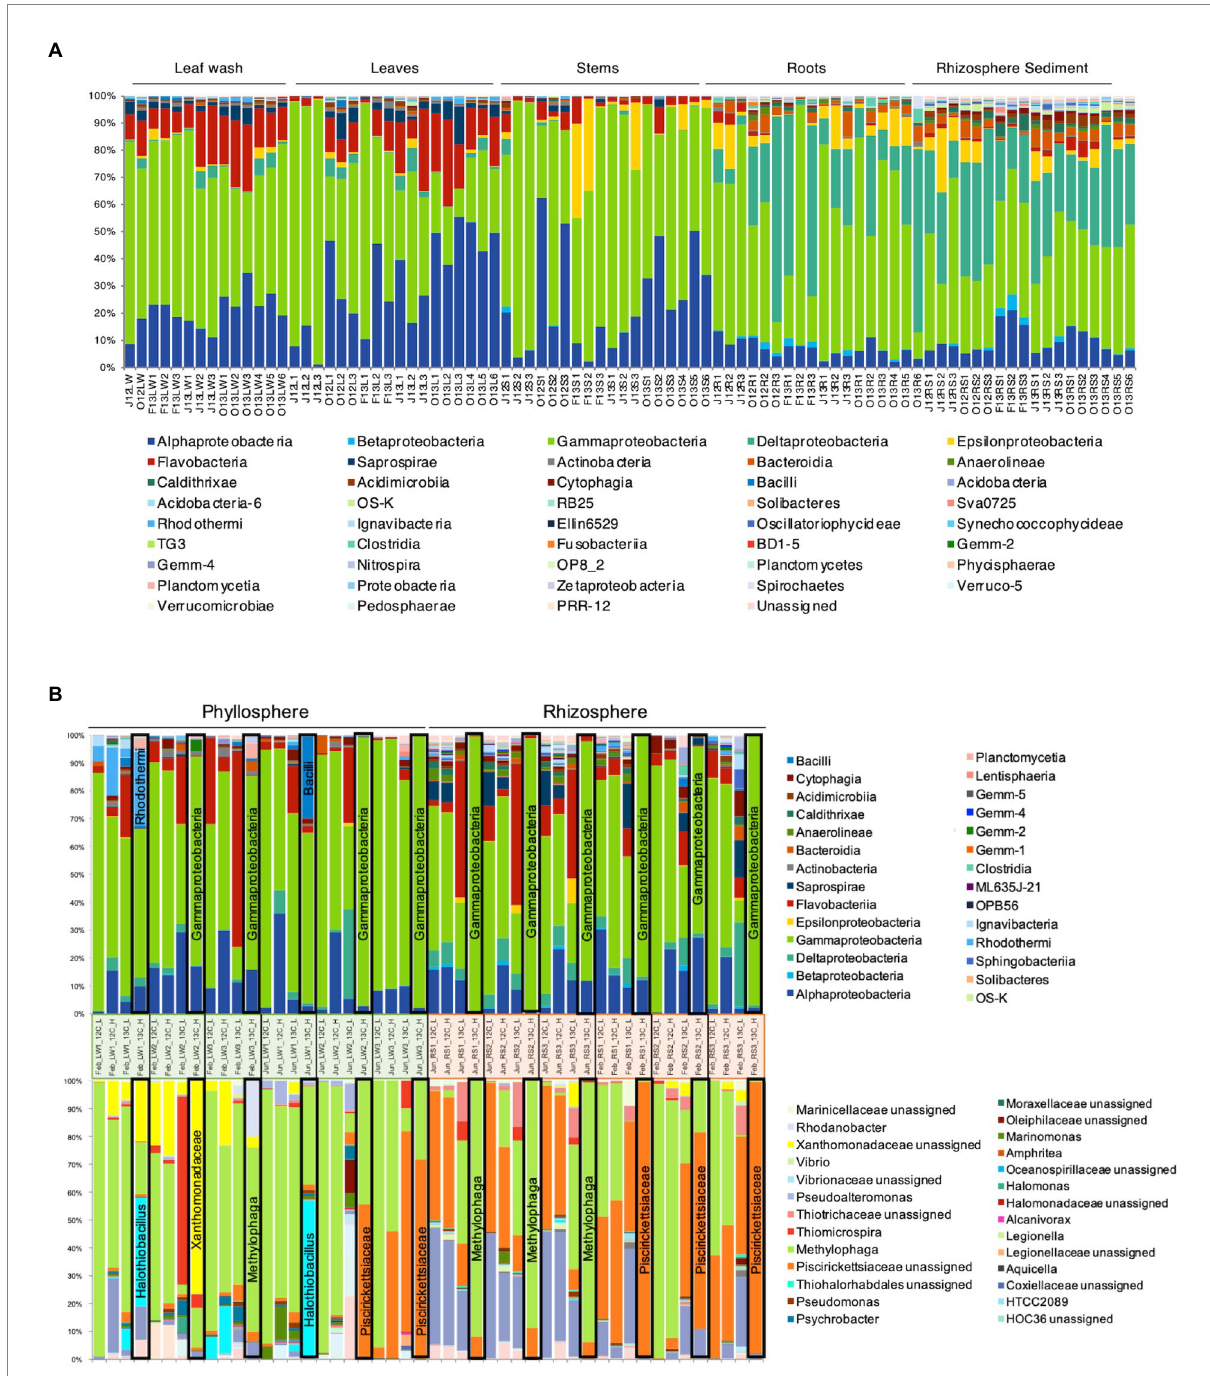
FIGURE 4 Bacterial community composition in phyllosphere and rhizosphere of Sporobolus anglicus . (A) Bacterial community composition in leaf wash (LW), leaf (L), stem (S), root (R), and rhizosphere sediment (RS) samples of S. anglicus in June 2012 (J12), October 2012 (O12), February 2013 (F13), June 2013 (J13), and October 2013 (O13) at class-level. Each column represents relative abundance of microbial taxa detected in a sample. (B) Relative distribution and phylogenetic affiliation of OTUs detected by bacterial 16S rRNA high-throughput amplicon sequencing of fractionated DNA from [ 13 C 2 ]-DMS and [ 12 C 2 ]-DMS SIP incubations of phyllosphere (leaf washings—LW) and rhizosphere samples (sediment—RS) of S. anglicus from June and February at class-level (top) and genus-level (bottom, most abundant genera) after incorporation of 100 μ mol C g –1 sample. Each column represents relative abundance of microbial taxa detected in a sample. Columns marked with a black frame are 13 C-“heavy” fractions that should represent the enriched community under [ 13 C 2 ]-DMS treatment and therefore the active DMS-degrading